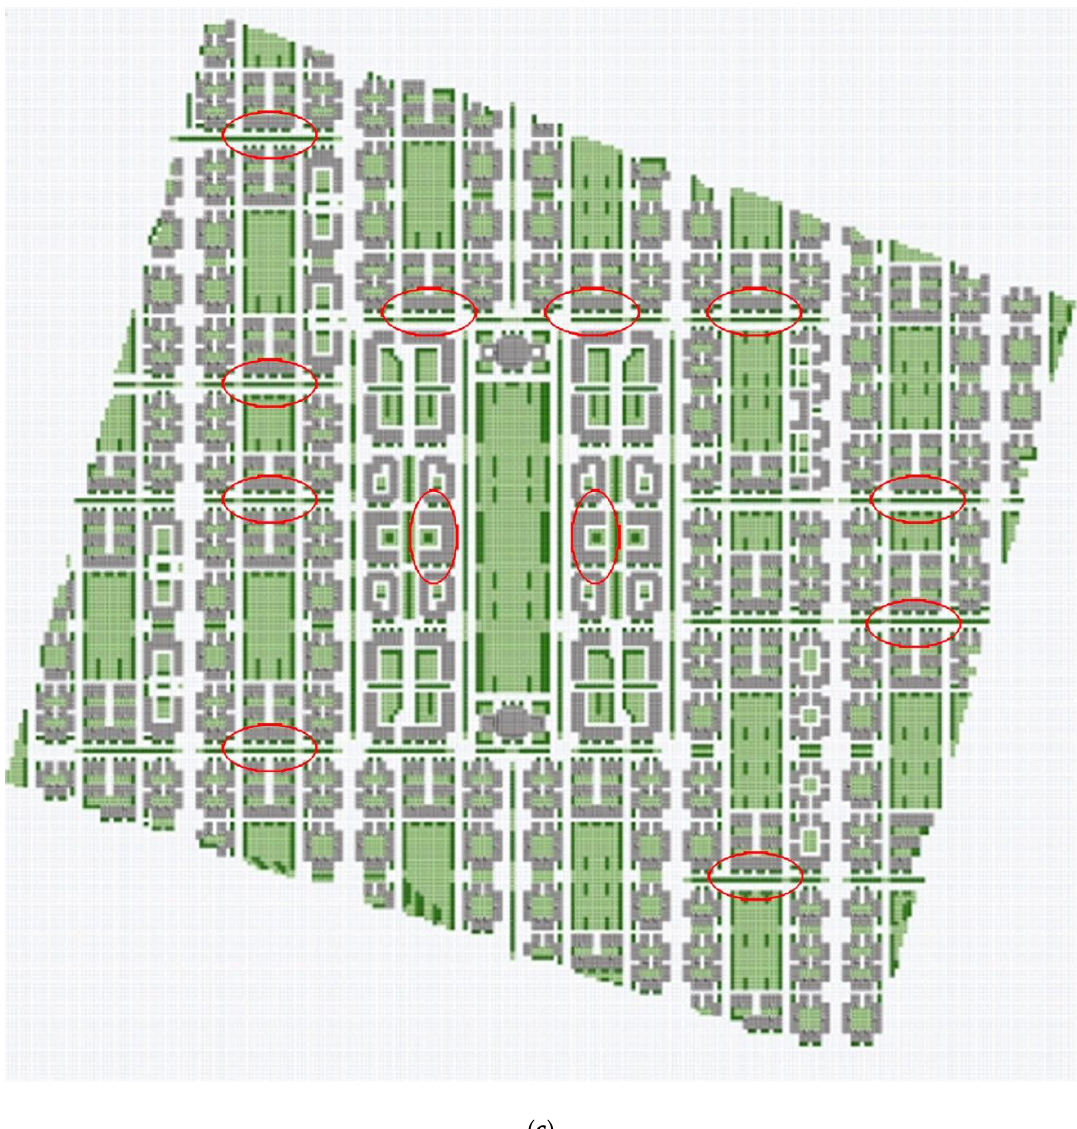
Figure 8. Master plans of ( a ) BC1, ( b ) C1DS1, and ( c ) C1DS2; buildings in grey, grass in light green, and trees in dark green. The red ellipses indicate the location of high buildings used to help Urban Canopy Layer (UCL) wind mixing.